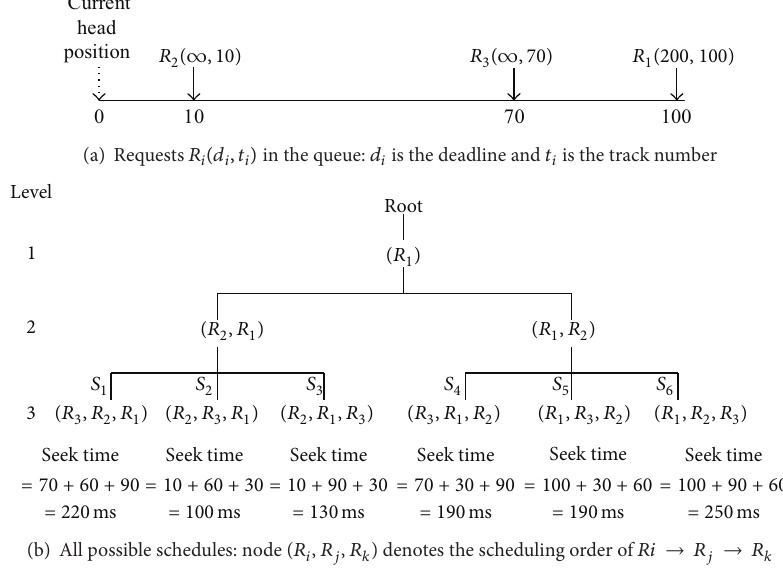
Figure 2: An example for pruning. There are three requests 𝑅 1 , 𝑅 2 , and 𝑅 3 in the queue. Schedules 𝑆 1 and 𝑆 6 can be pruned because 𝑆 1 misses the deadline 200 ms of 𝑅 1 , and 𝑆 6 incurs too long seek